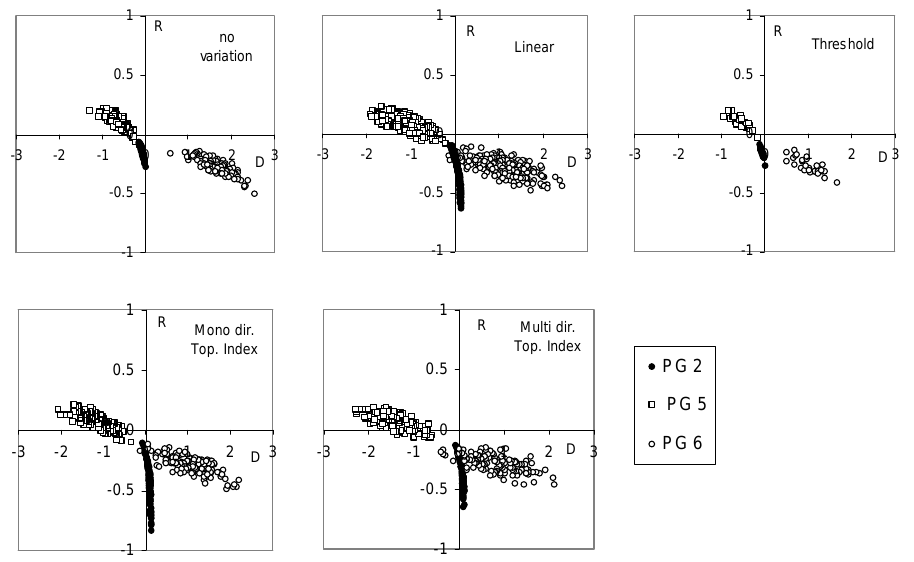
Fig. 6. Mean error ( D ) versus log of relative range of variations ( R ) of water table depth, computed for the selected simulations